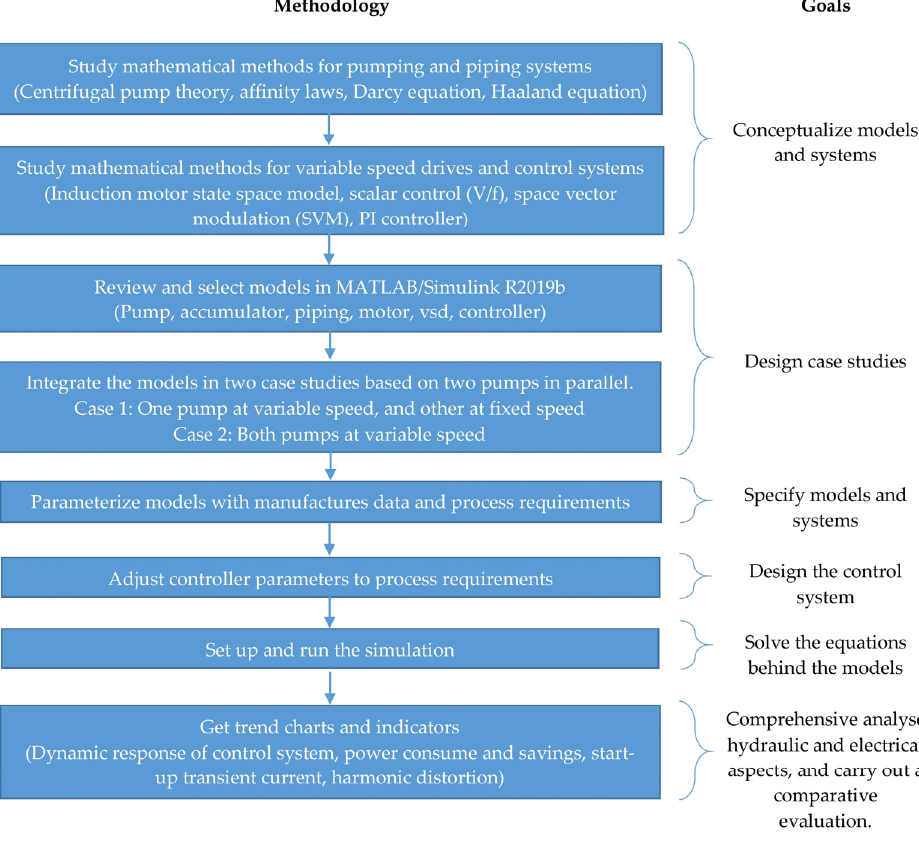
Figure 1. Flow diagram of methodology.